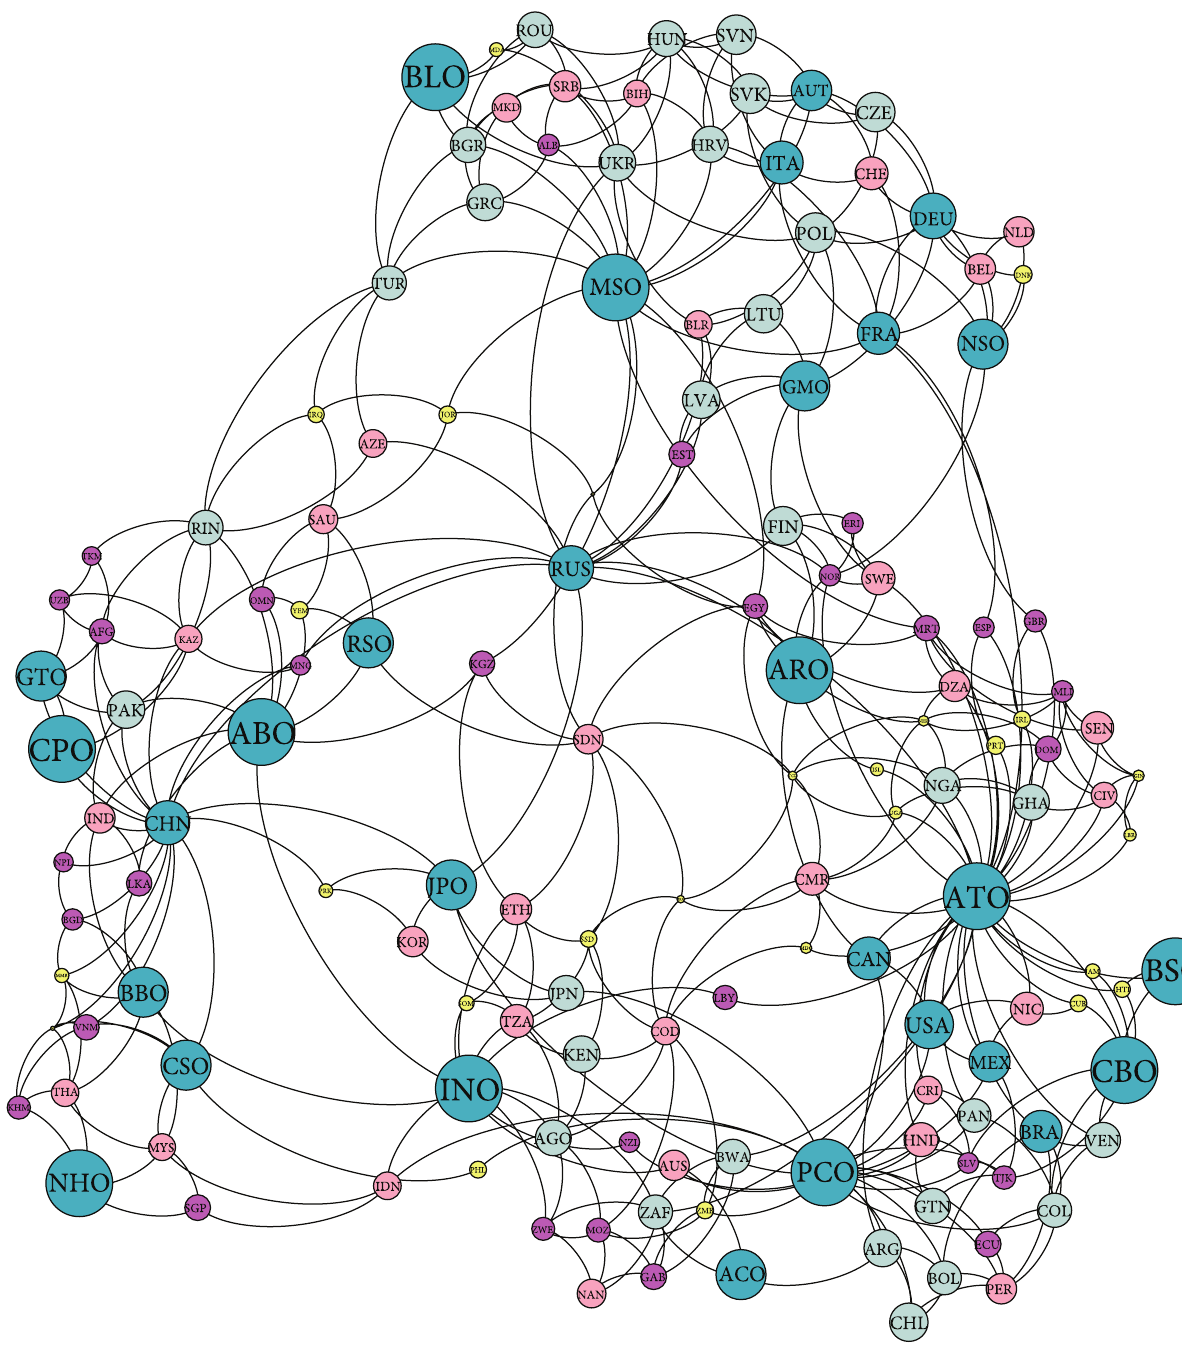
Figure 2: The 145-nation (including 19 oceans) network, where edges represent the geographically neighboring relationship. The positions of the nodes are drawn according to their respective centrality index, regardless of the geographical positions. The size of each node is set according to the stationary value of